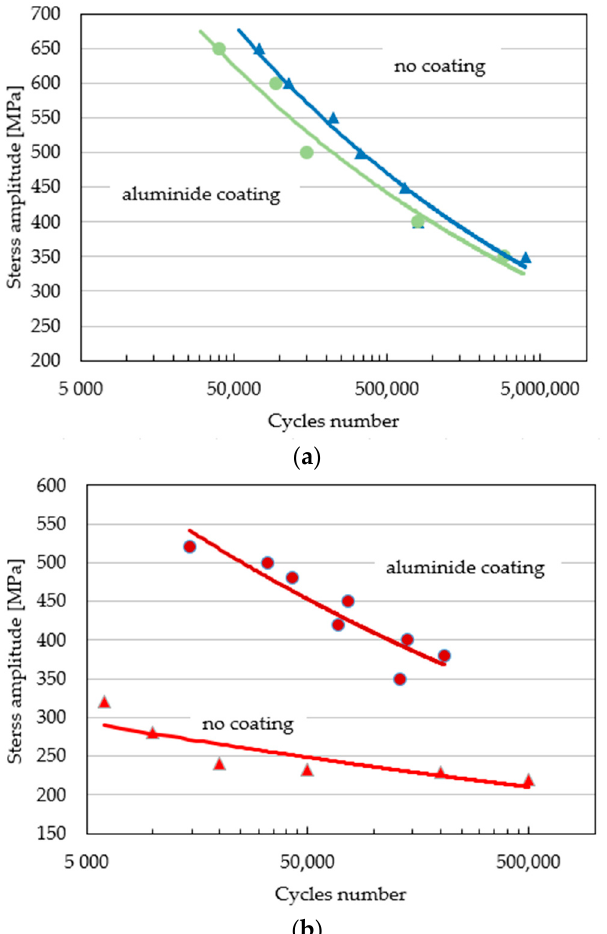
Figure 4. S-N curves of coated and uncoated MAR247 nickel based superalloy determined at: ( a ) room temperature; ( b ) 900 °C. ( a ) room temperature; ( b ) 900 ◦